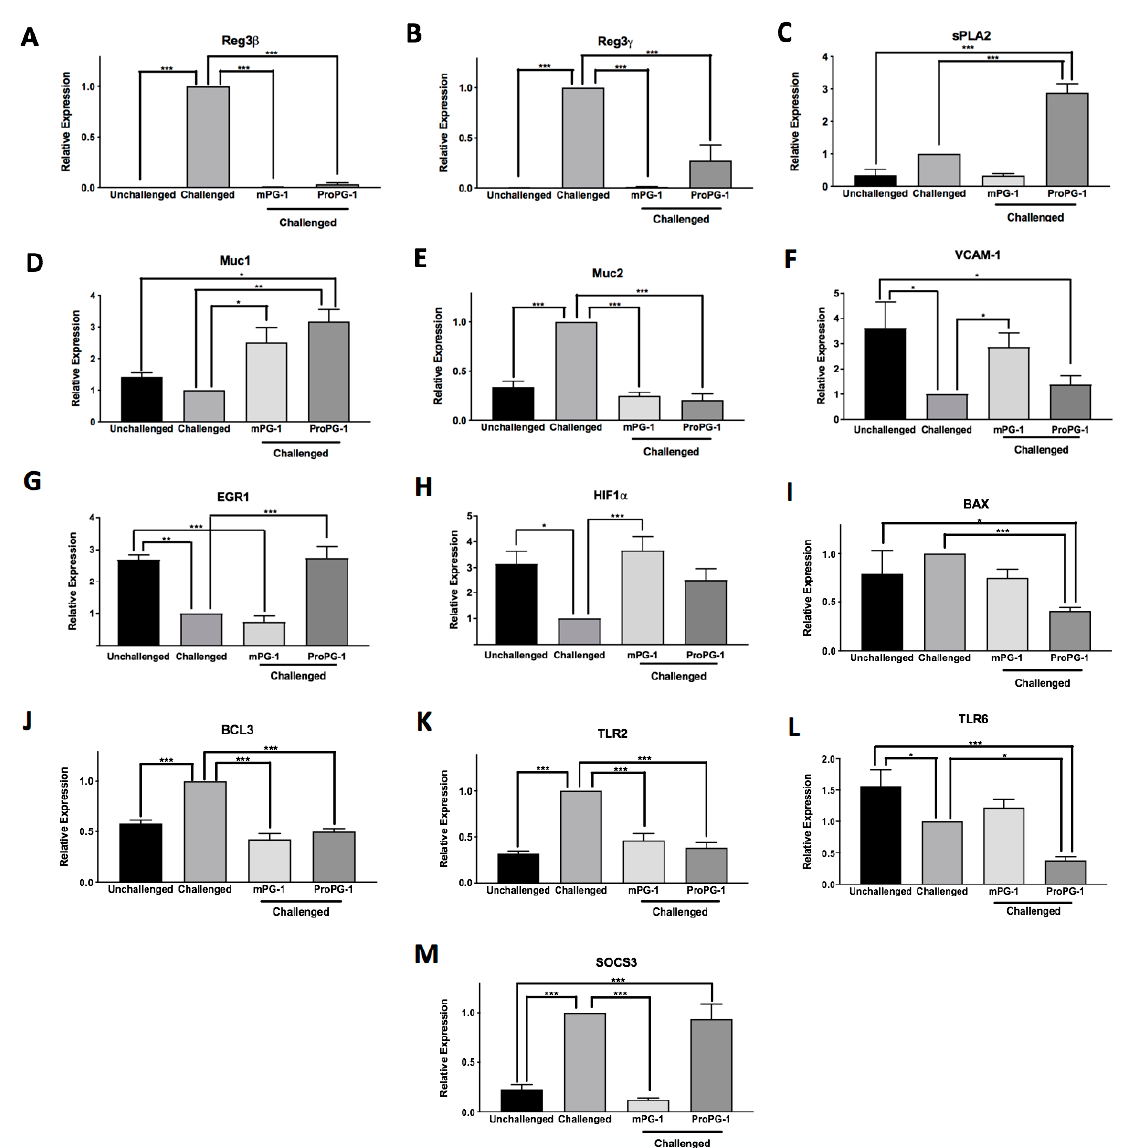
Figure 4. Effects of PG-1 on antimicrobial peptide (AMP) gene expression ( A – C ), self-protecting gene expression ( D – H ), and apoptotic, innate immune response, and cytokine gene expression ( H – M ) within the colon. Protegrin treatments differentially affect gene expression of the AMPs Reg3 β ( A ), Reg3 γ ( B ), and sPLA2 ( C ), Muc1 ( D ), Muc2 ( E ), cell adhesion molecule VCAM-1 ( F ), cell proliferation gene EGR1 ( G ), stress response factor HIF1 α ( H ), apoptotic markers BAX ( I ) and BCL3 ( J ), innate immune response genes TLR2 ( L ) and TLR6 ( L ), and the cytokine regulator SOCS3 ( M ). Colonic gene expression levels were determined by RT-qPCR, with values normalized against GAPDH and β -actin. Data represent the mean ± SEM; * p < 0.05, ** p < 0.01, *** p < 0.001 compared to controls calculated by a one-way ANOVA post hoc Tukey test. All values in gene expression analysis were compared to those of challenged mice set to a relative expression of 1.